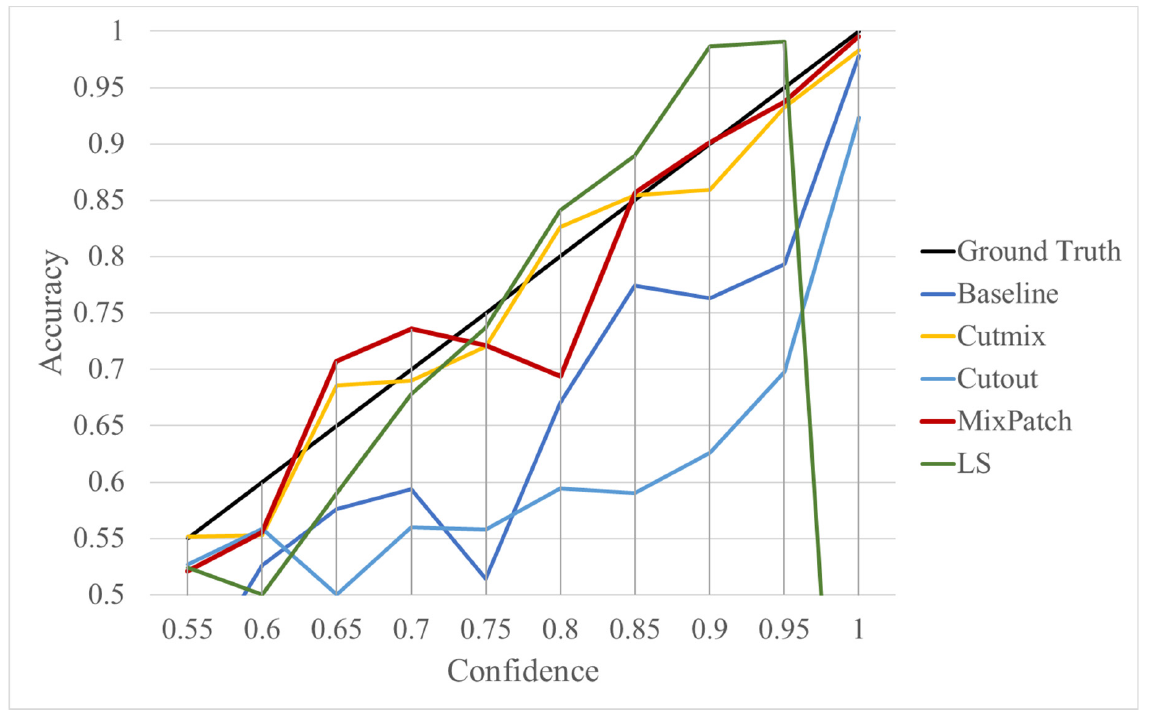
Figure 4. Integrated reliability diagram for patch-level classifiers trained using each method. Table 5. Performance comparison of the alternative methods .